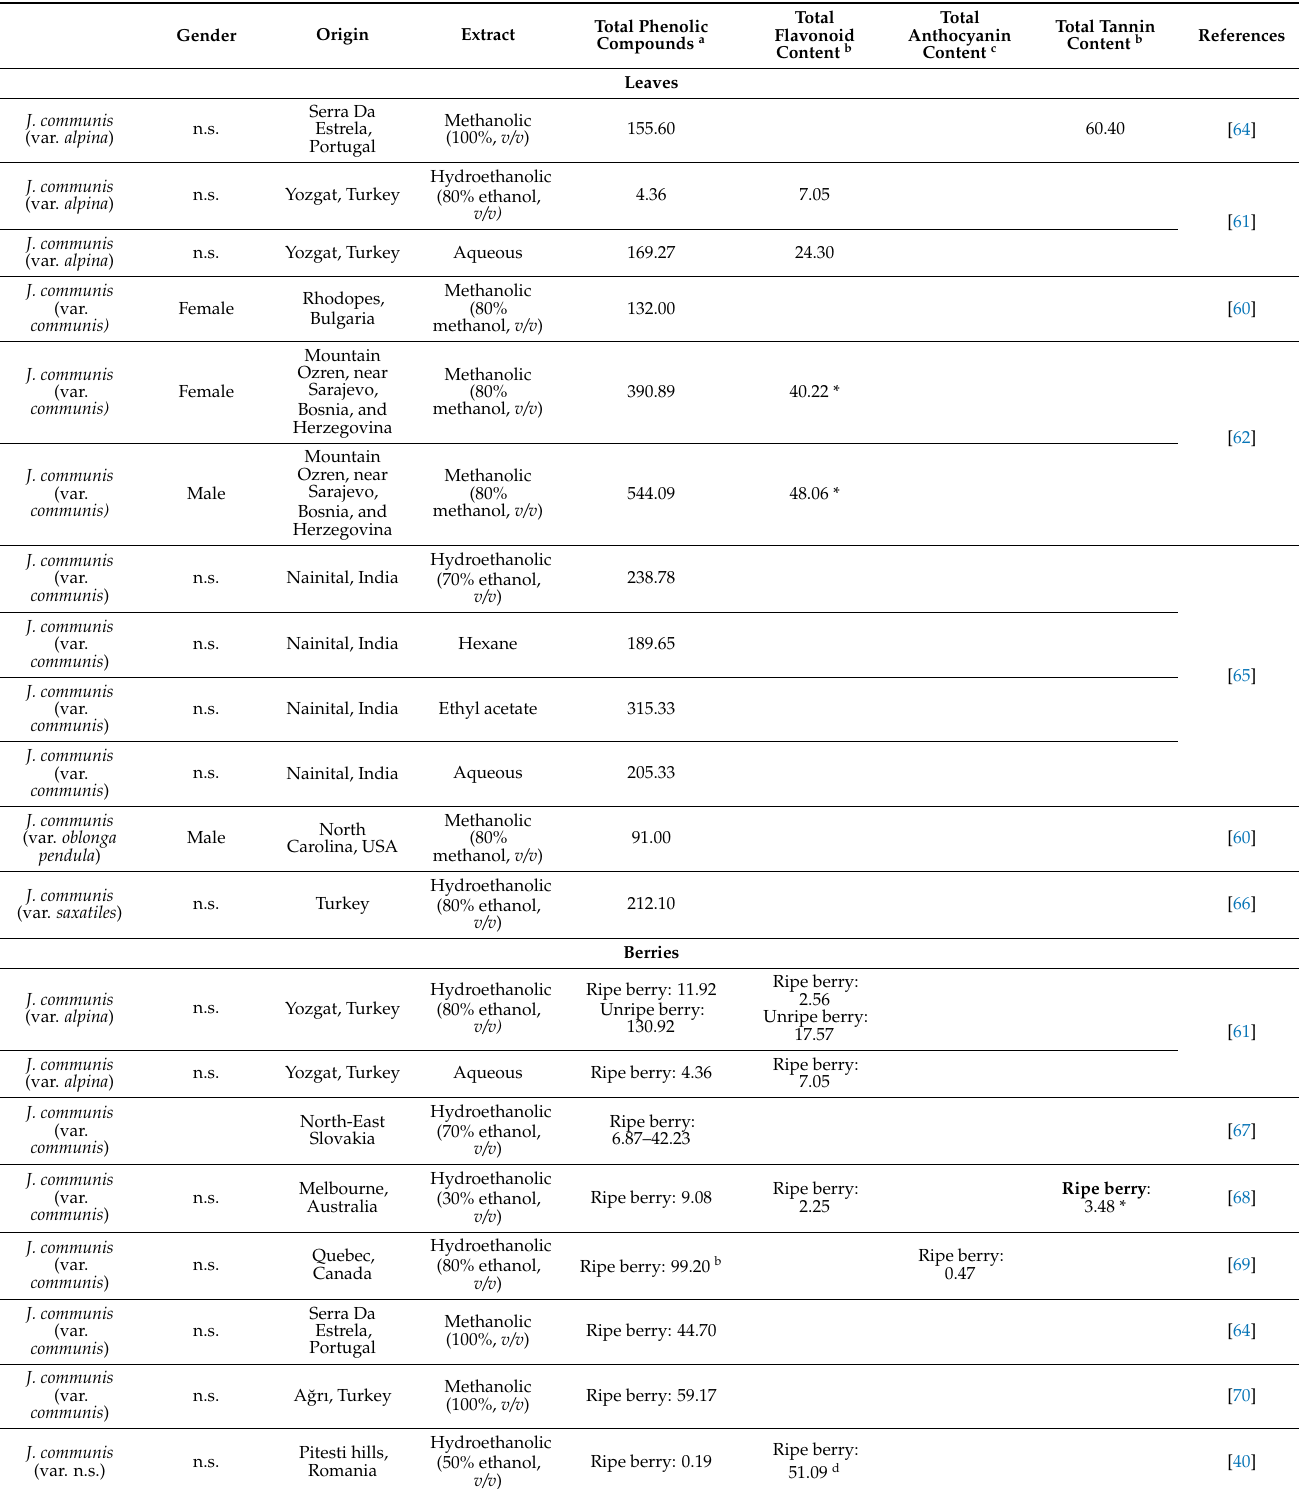
Table 1. Total phenolic, flavonoid, anthocyanin, and tannin content of different Juniperus communis L. plant parts